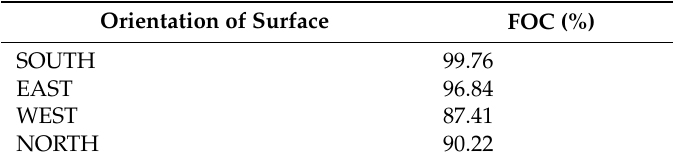
Table 7. Frequency of occurrence (FOC) of VSC values higher than 27% for surfaces facing the four cardinal orientations.